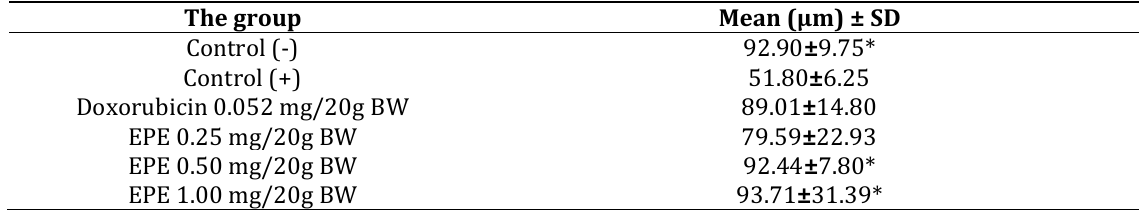
Table II. Mean data of colonic crypt length in the BALB/c mice colon of the CAC model after treatment with EPE. Four mice of each group were sacrificed to conduct HE staining of colon tissue then observed using a microscope. The length of cryptic cells (µm) were measure using Image Raster 3.0 software.